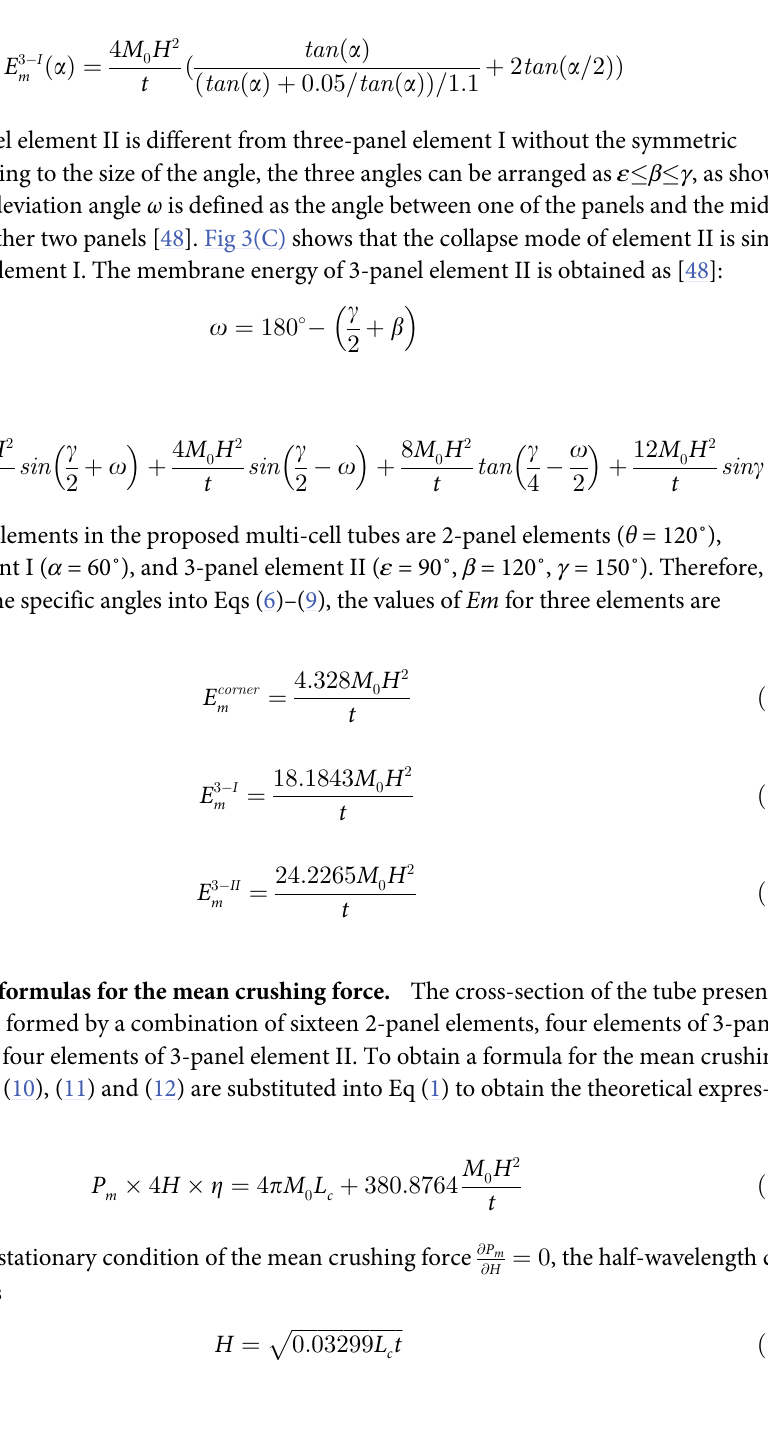
ffiffiffiffiffiffiffiffiffiffiffiffiffiffiffiffiffiffiffiffiffiffi 0 : 03299 L